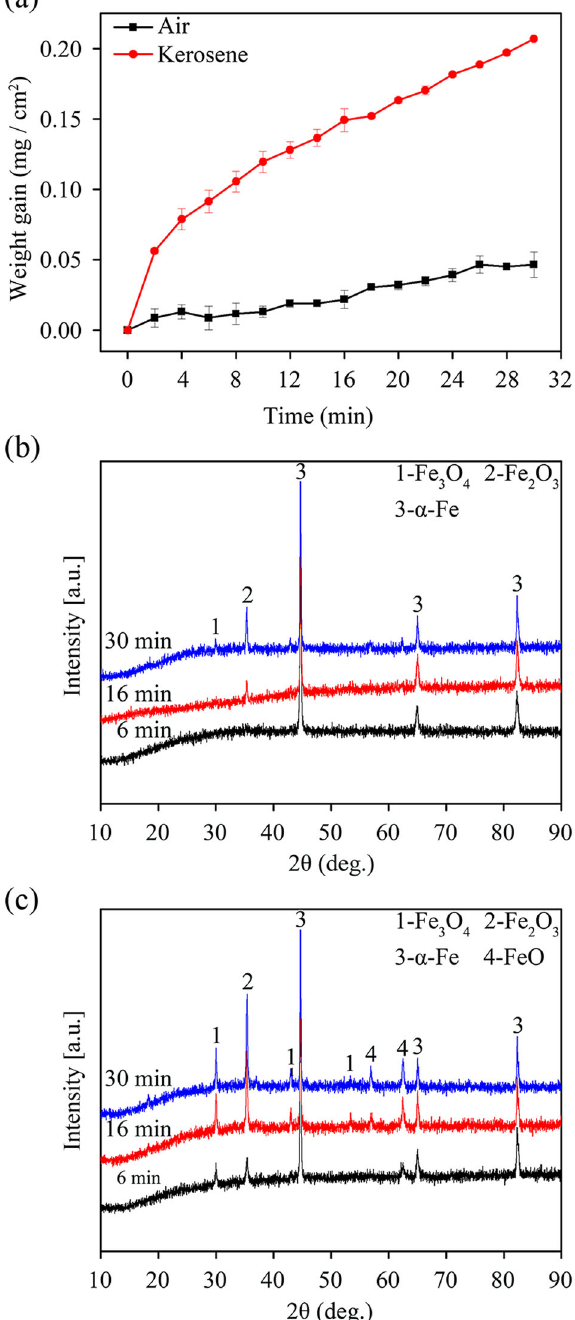
Fig. 2 The high-temperature oxidation at 600 °C. a oxidation kinetics of 37Mn5 steels after oxidation for 30 min. b XRD patterns of 37Mn5 steels after oxidation in air. c XRD patterns of 37Mn5 steels after oxidation in